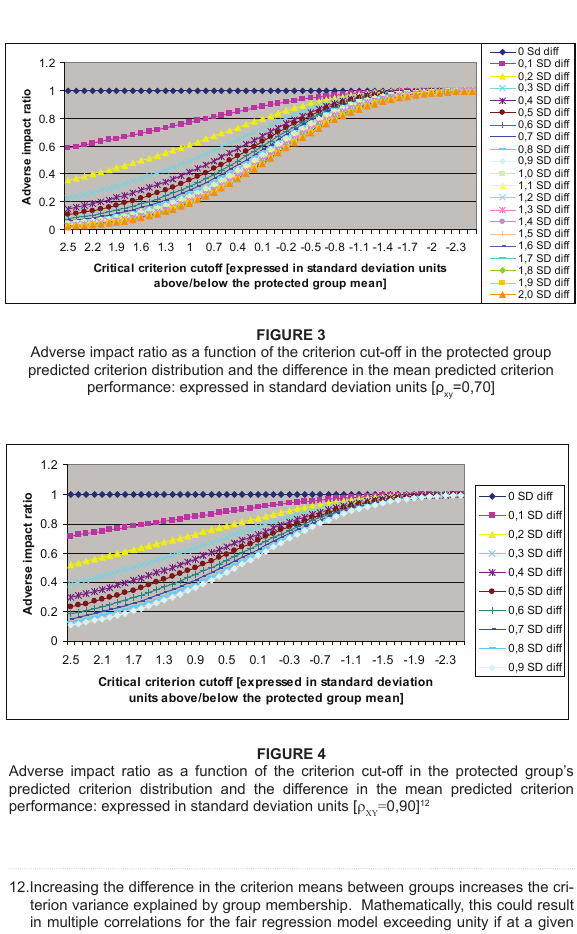
12.Increasing the difference in the criterion means between groups increases the cri- terion variance explained by group membership. Mathematically, this could